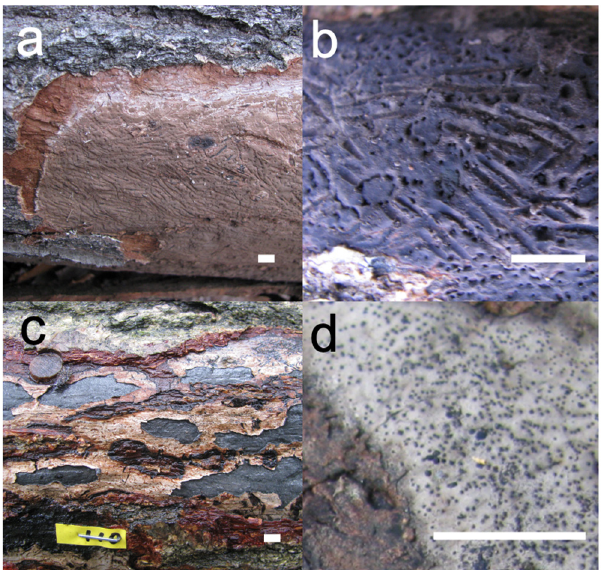
Figure 1. ( a ) Surface of a Quercus serrata log recently debarked by a squirrel. Powdery ascomycete anamorph appears at the centre of the debarked portion where numerous scratch scars can be observed, March 2016. ( b ) Zoomed in picture of the scratched anamorph surface, March 2016. ( c ) Gradual peeling of the anamorph surface (brown portion) and appearance of the teleomorph surface (grey portion), June 2016. ( d ) Zoomed in picture of teleomorph, which was identified as Biscogniauxia maritima and Biscogniauxia plana by Dr. Shuhei Takemoto from the University of Tokyo, July 2016. Scale bars: 5 mm.